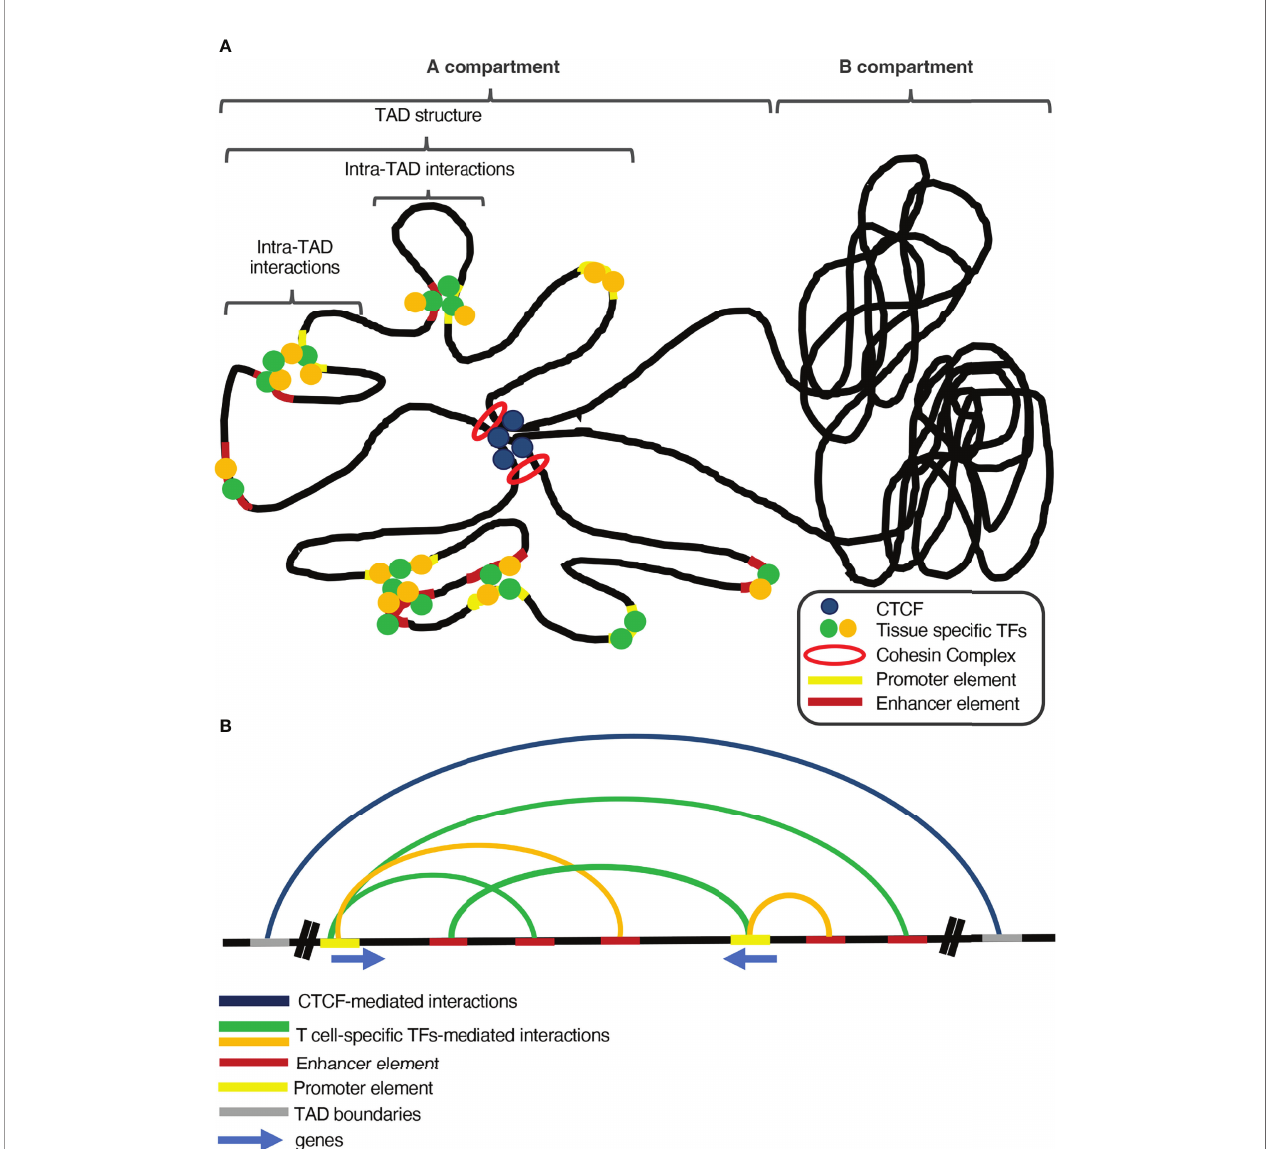
FIGURE 1 | The interplay between global and tissue-speci fi c genome organizers and transcription factors is vital for tissue-speci fi c gene regulation. (A) Global genome organizers (such as CTCF and the Cohesin Complex) safeguard the genomic integrity and shape the general structure of the genome, by insulating the Topologically Associating Domains (TADs) from each other. Additionally, loop extrusion within TADs facilitates long-range chromatin interactions between regulatory elements and genes. Under the control of the aforementioned global organizers and inside such sub-structures of the genome, tissue-speci fi c transcription factors and chromatin remodeling complexes control proper spatiotemporal gene expression, during development and differentiation. (B) Global genome organizers cooperate with tissue-speci fi c transcription factors and chromatin organizers to sustain tissue-speci fi c transcription